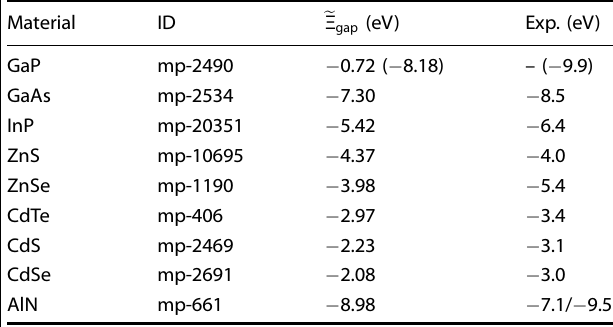
Fig. 3 e Ξ gap vs. gap heat map. Density plot of e Ξ gap with respect to the band gap. The values are calculated within the PBE approximation. Table 2. Comparison to experimental